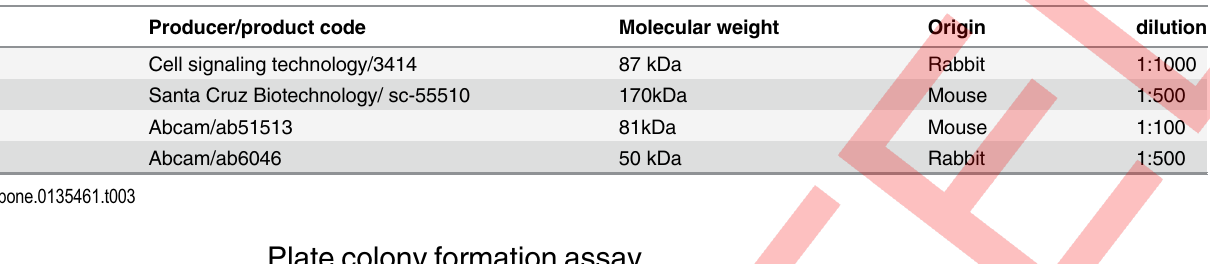
S1 Table. The lncRNA expression profiling data.